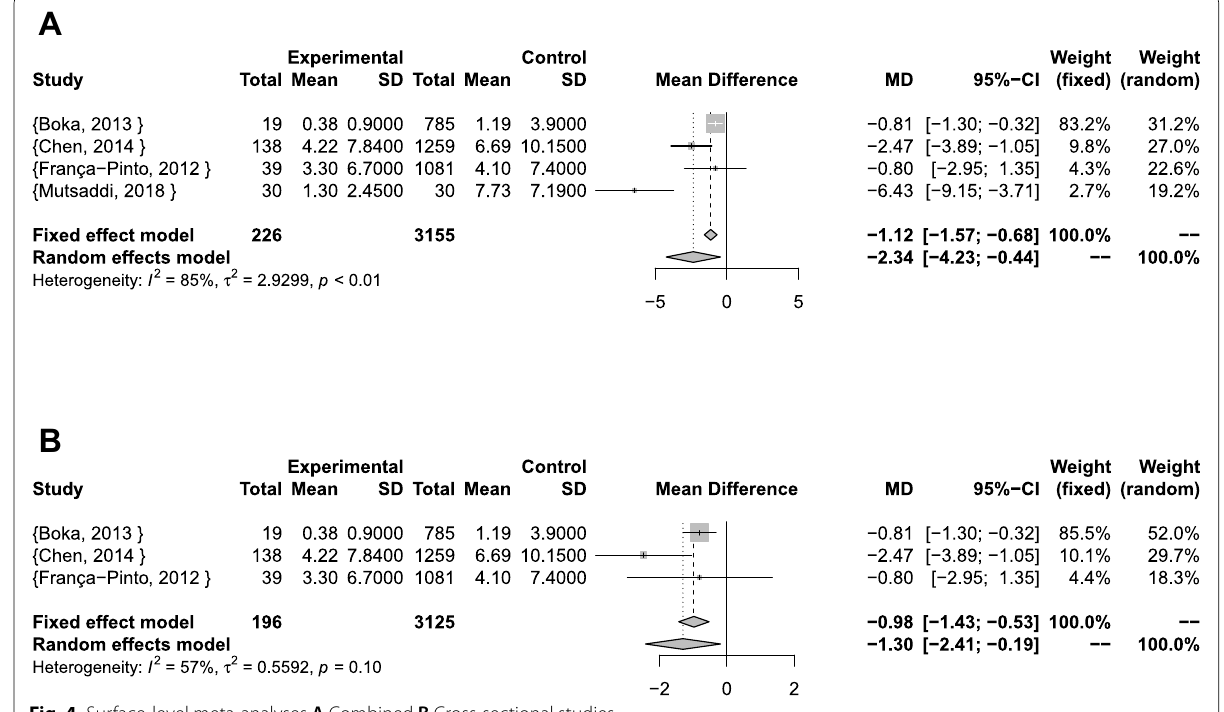
Fig. 4 Surface-level meta-analyses A Combined B Cross-sectional